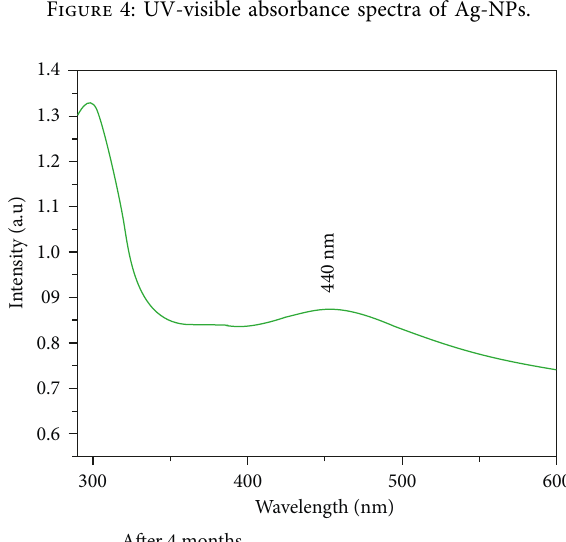
Figure 4: UV-visible absorbance spectra of Ag-NPs.